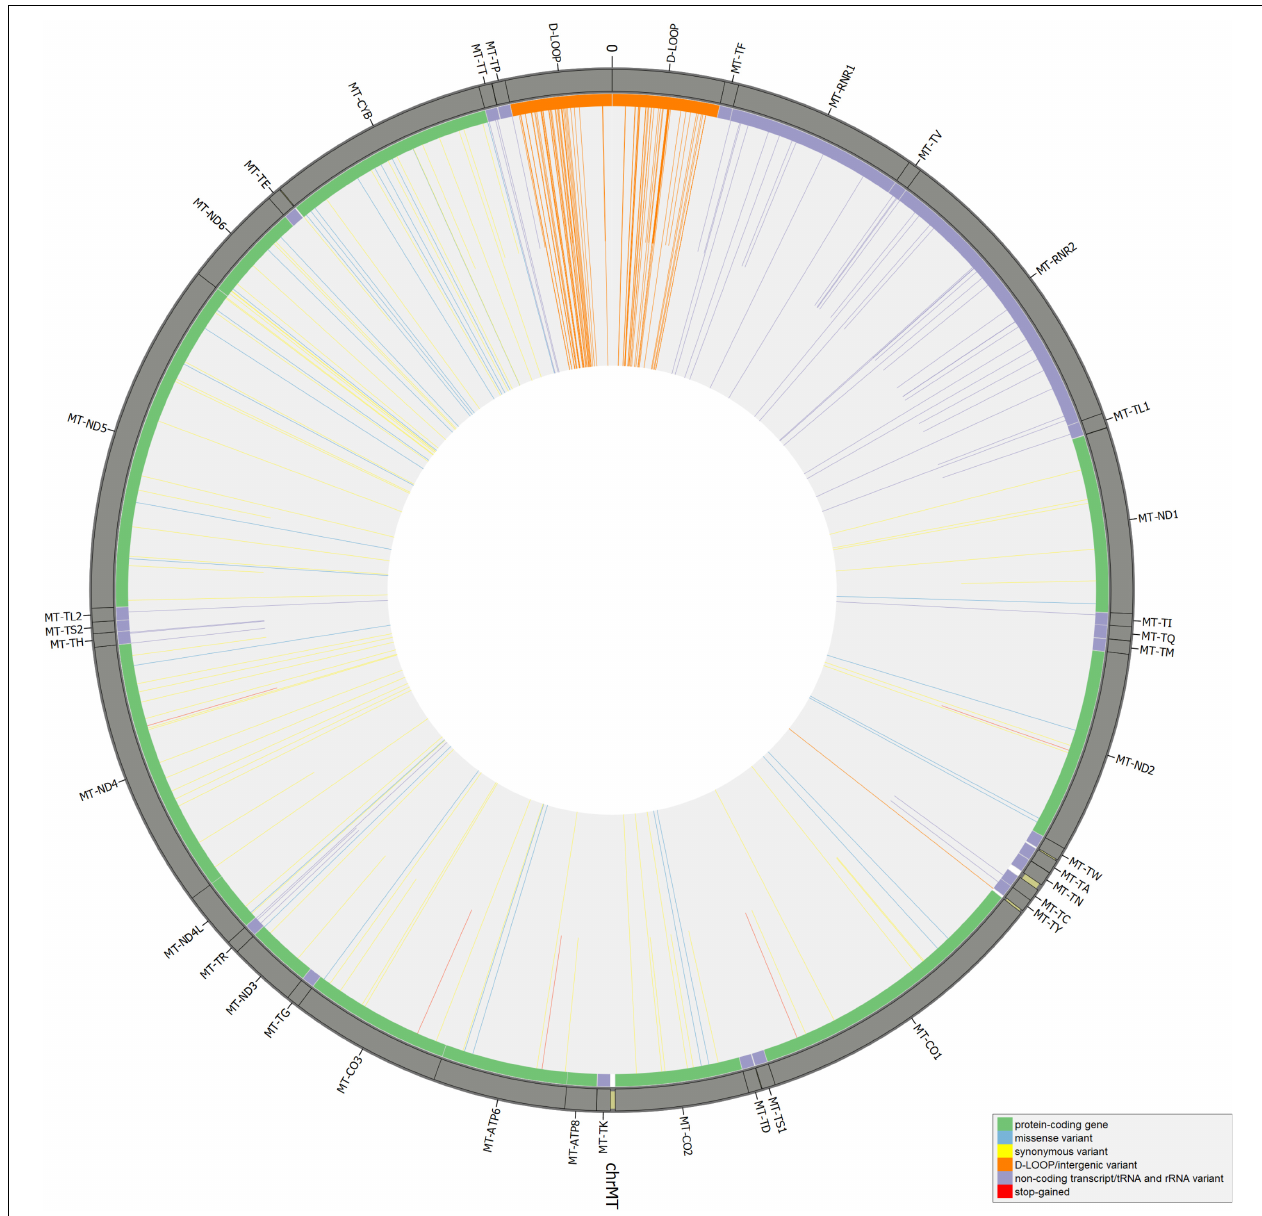
FIGURE 6 | Distribution of mitochondrial DNA (mtDNA) variants in the whole Polizzello dataset. Longer bars refer to variants above the allele fraction (AF) threshold (50); shorter bars refer to variants under the threshold (possible low-to-mid